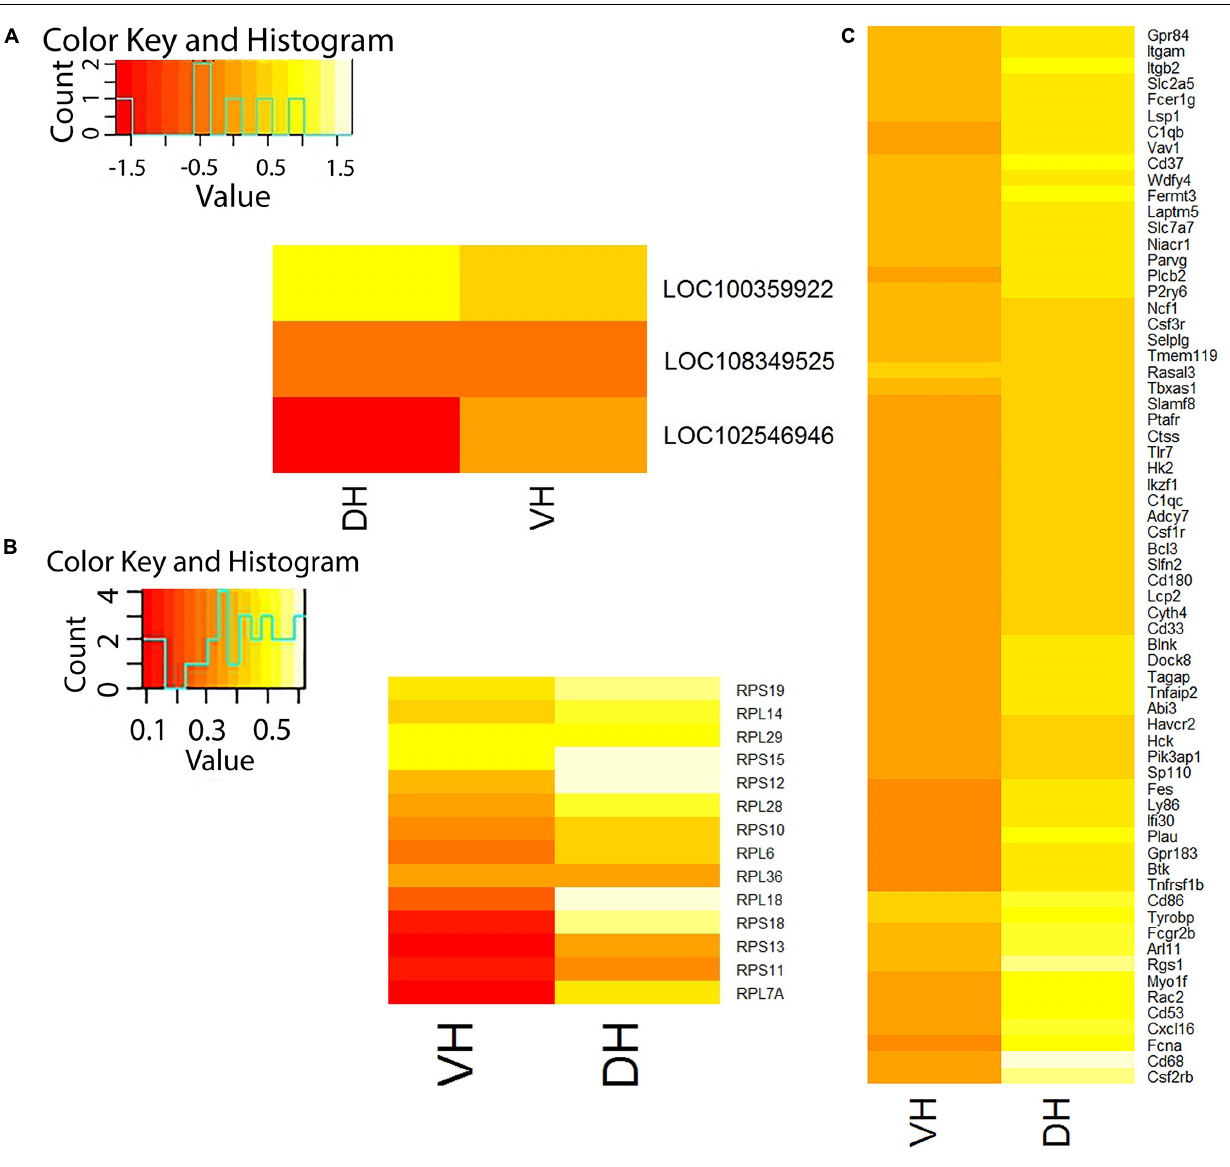
FIGURE 2 | Differentially expressed genes in the dorsal (DH) and ventral (VH) hippocampus after treatment with Ig-saporin. (A) Heatmap shows differential expression of non-coding RNAs in VH and DH. (B) Heatmap shows differential expression of ribosome-forming genes in VH and DH. (C) Heatmap shows differential expression of microglia-specific genes in VH and DH. It may be seen that DH is stronger affected by Ig-saporin than